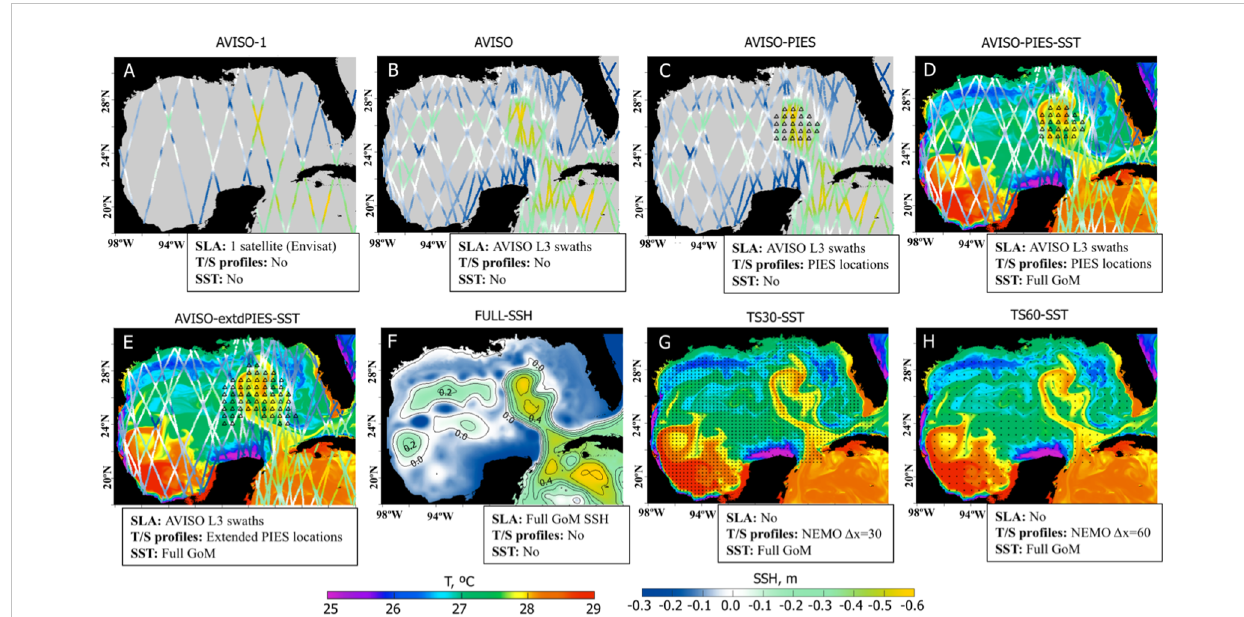
FIGURE 7 Design of the OSSEs. The maps show data fi elds assimilated into the OSSE hindcasts. Assimilated fi elds are listed below the maps. (A) SLA from one (Envisat) satellite (4 days composite). The colored lines show NEMO SSH (Nature Run) on June 1, 2011 interpolated into satellite swaths. (B) Same as (A) but all available satellites on the analysis day (4 days composite). (C) Same as (B) additionally with T/S pro fi les derived from PIES observations. (D) Same as (C) additionally with SST. This experiment replicates the most complete set of observations presently available for assimilated runs. The colored fi eld in the background shows SST from the NEMO NR (June 1, 2011). (E) Same as (D) but with T/S pro fi les from extended PIES. (F) Full SSH fi eld from the NEMO NR (June 1, 2011). (G) T/S pro fi les at every 30th NEMO grid point and SST. (H) T/S pro fi les at every 60th NEMO grid point and